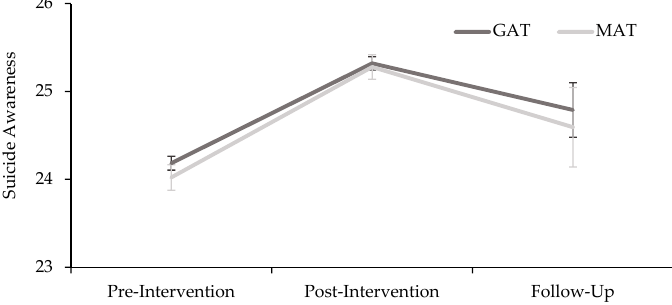
Table 3. Fixed effect estimates for help-seeking intention.